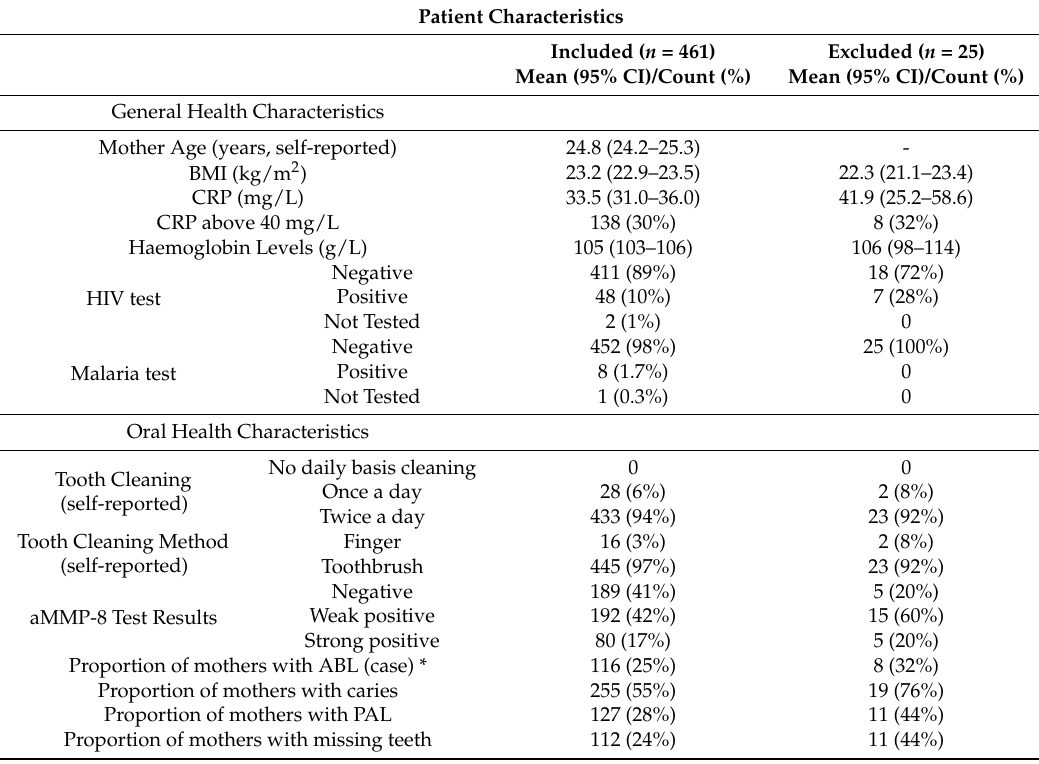
Table 1. Characteristics of included and excluded